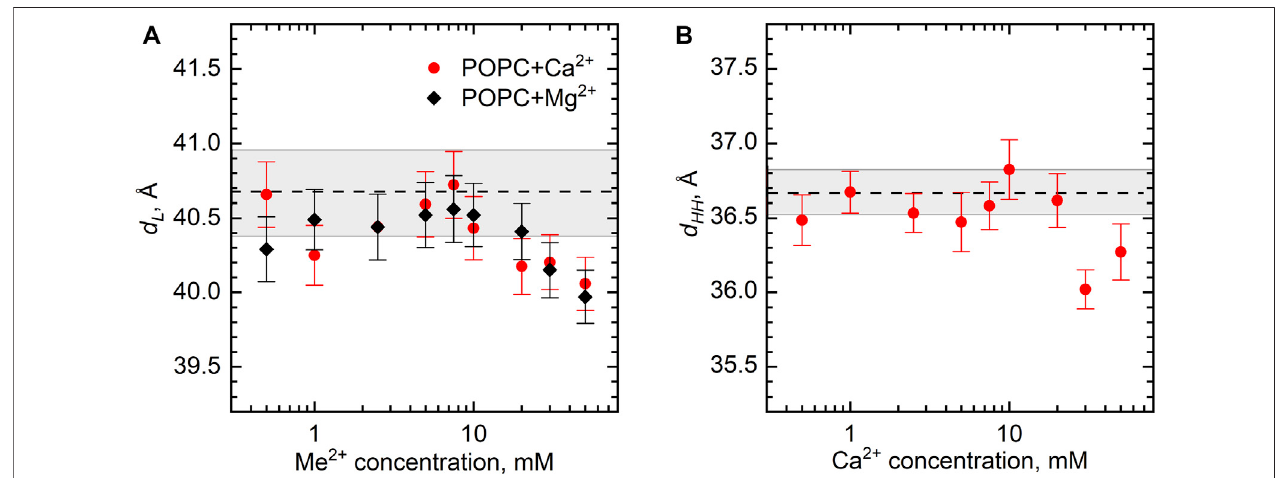
FIGURE 5 | The changes of POPC bilayer thickness ( d 2+ and Mg 2+ concentrations at 25 ° C according to (A) SANS and (B) SAXS L and d HH ) as a function of Ca measurements. Dashed lines represent d L and d HH of neat POPC ULVs with the wide gray bands depicting their standard